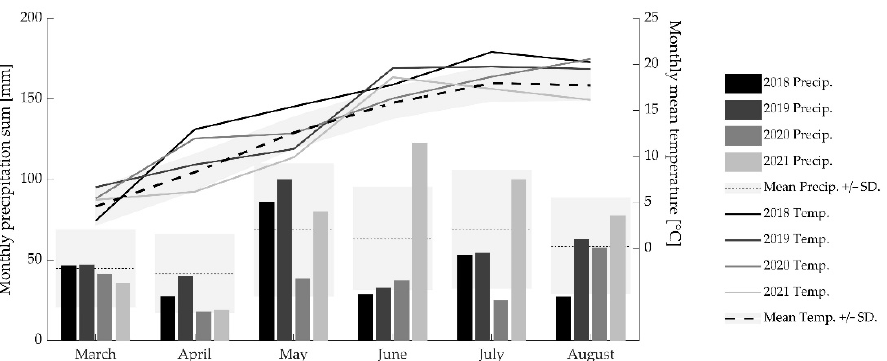
Figure 3. Meteorological data from the weather station Ruppertsecken from German Weather Ser- vice (DWD). Monthly sums of precipitation and mean temperatures for the vegetation periods in years 2018, 2019, 2020 and 2021 are shown in comparison to the long-term average (1969 to 2021).